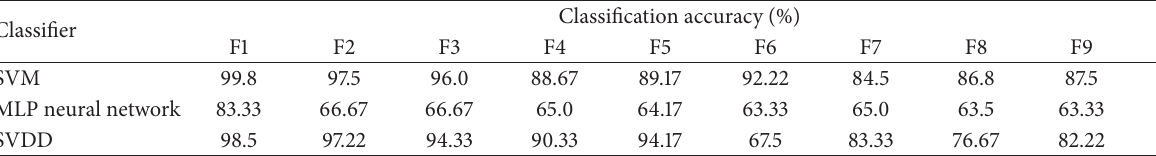
Table 3: Comparison of fault classification results based on three classifiers and ten types of reduced feature sets.